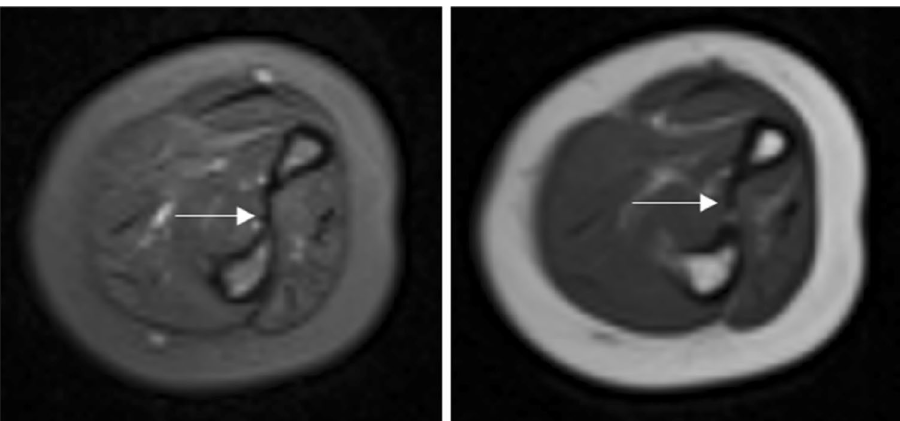
Figure 5. Axial T1 and T2-weighted images of the forearm (case 10) demonstrated no obvious the injuries of the interosseous membrane (the arrow).